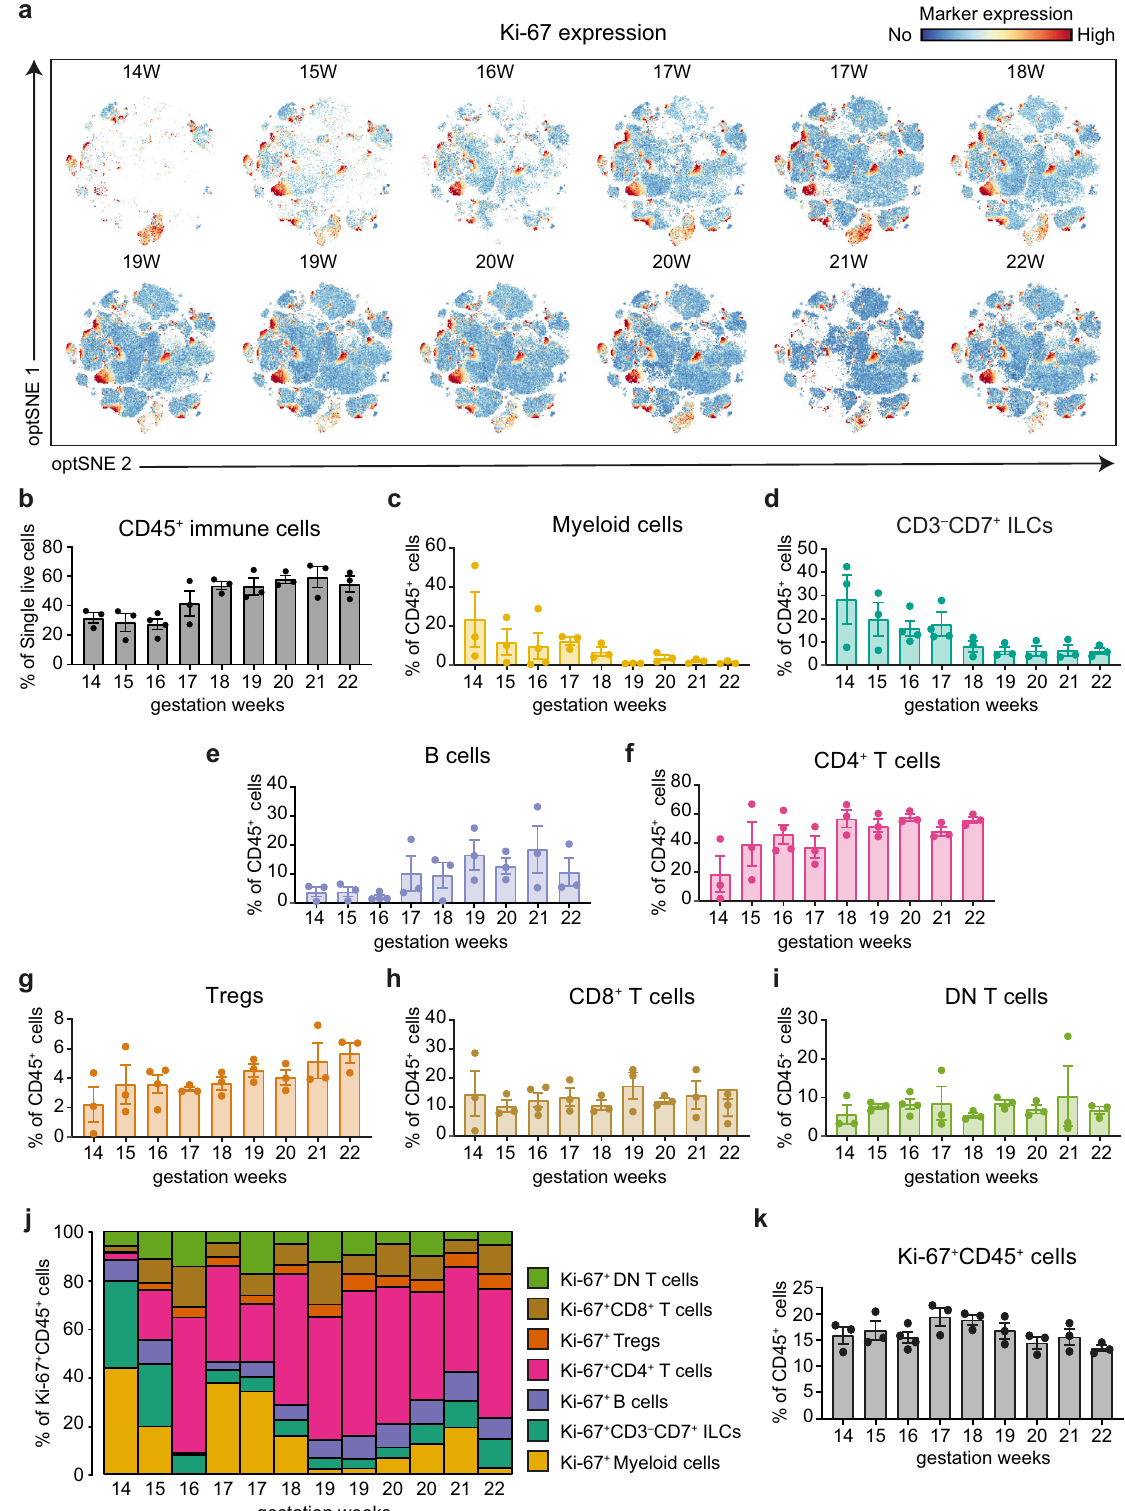
Fig. 2 | Presence of Ki-67 + cells throughout gestational week 14 to 22. a Display oftheKi-67expressionintheoptSNEplotsoftheindividualfetalintestinalsamples fromweek14through22.ColorsrepresenttherelativeexpressionofKi-67.Dataare representative of three independent experiments. b The frequency of CD45 + immune cells within all human fetal intestine samples analyzed ( n =28). Error bars indicatemean±s.e.m. c – i Overviewofthefrequencyofeachimmunelineagewithin